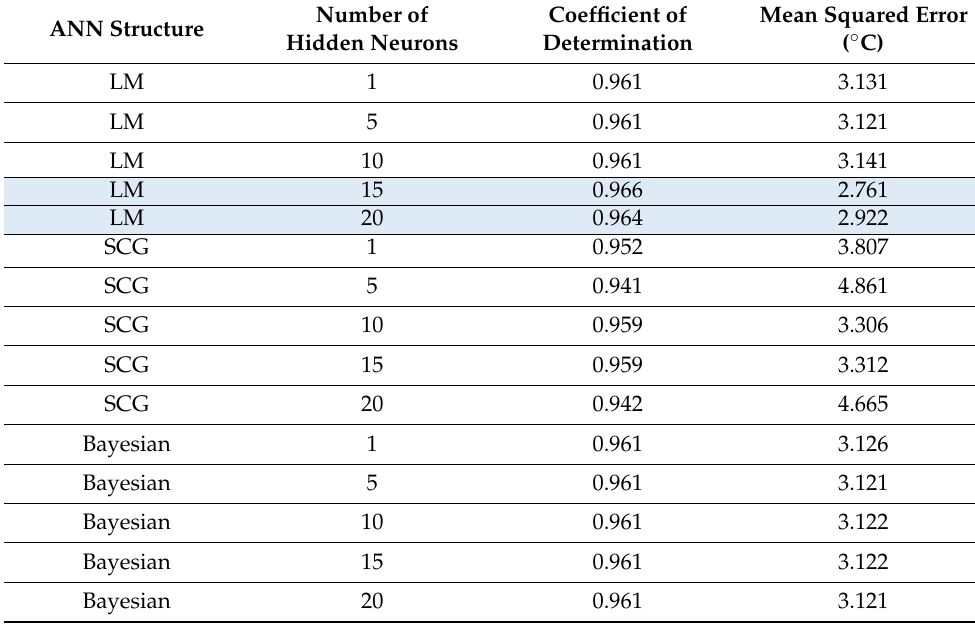
Table 3. Statistical analysis of the model results for the stack